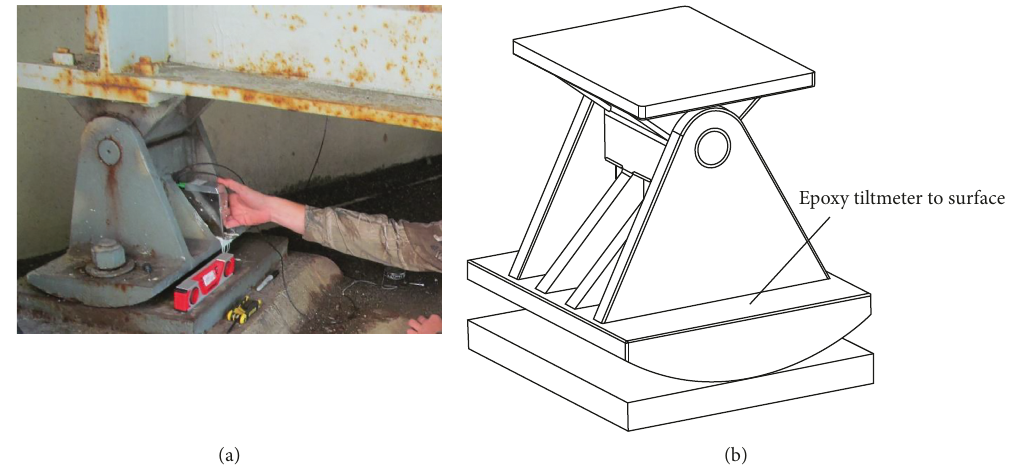
Figure 2: Picture of the tiltmeter: (a) installed tiltmeter on bearing and (b) three-dimensional drawing of bearing.